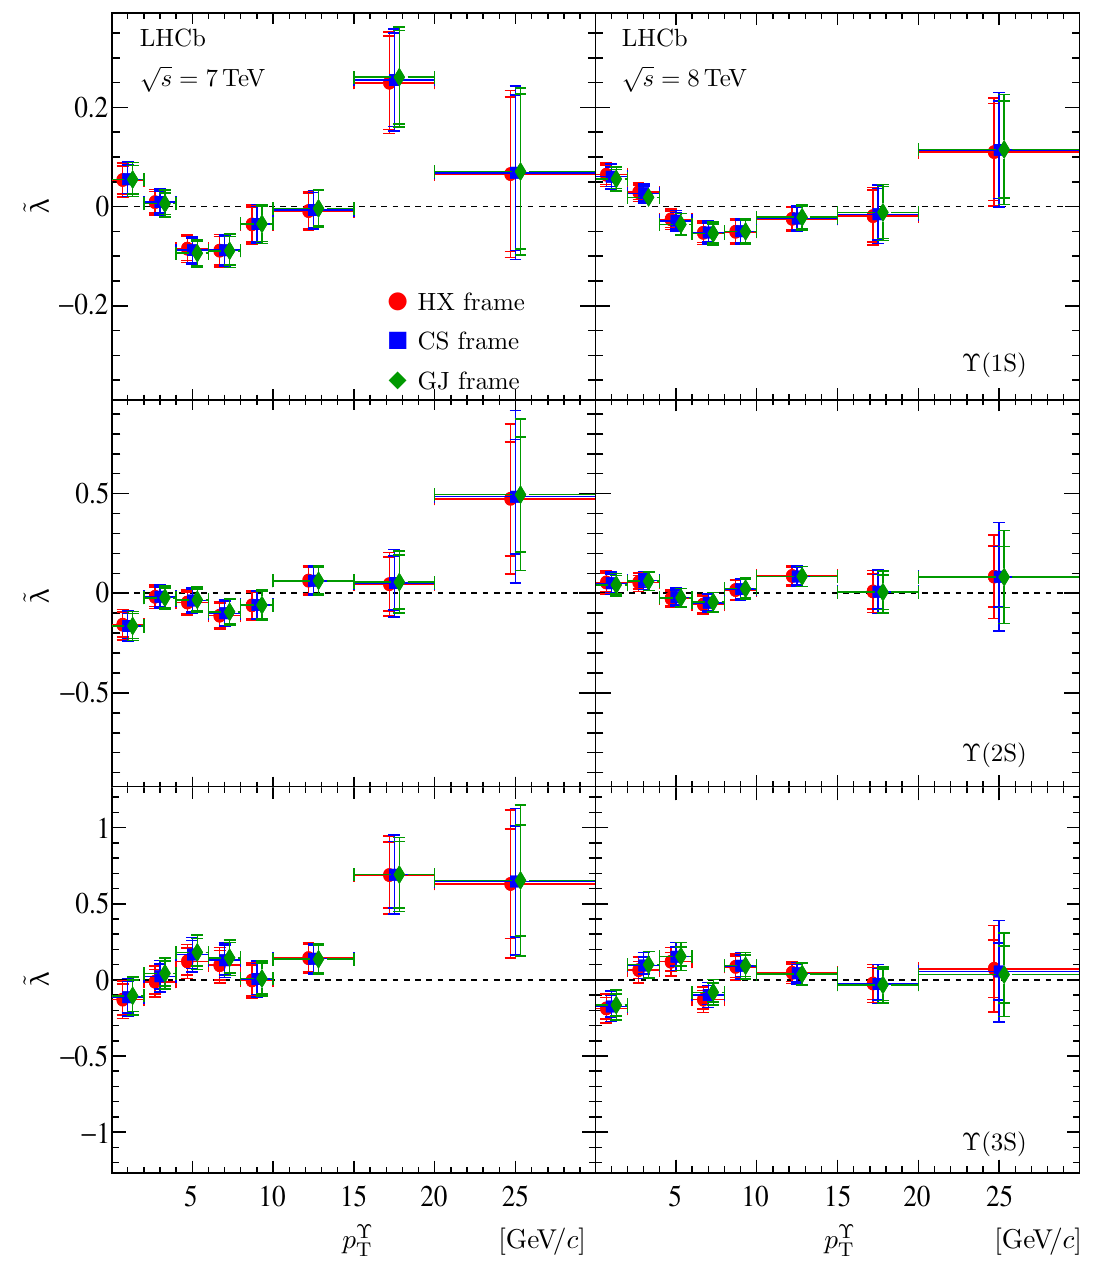
Figure 15 . The polarization parameter ~ (cid:21) for (top) (cid:7)(1S) mesons, (middle) (cid:7)(2S) mesons and (bottom) (cid:7)(3S) mesons as a function of p (cid:7) , for the rapidity range 2 : 2 < y (cid:7) < 4 : 5, for data T p p collected at (left) s = 7 TeV and (right) s = 8 TeV. The results for the HX, CS and GJ frames are shown with red circles, blue squares and green diamonds, respectively. The inner error bars indicate the statistical uncertainty, whilst the outer error bars indicate the sum of the statistical and systematic uncertainties added in quadrature. Some data points are displaced from the bin centers to improve visibility.